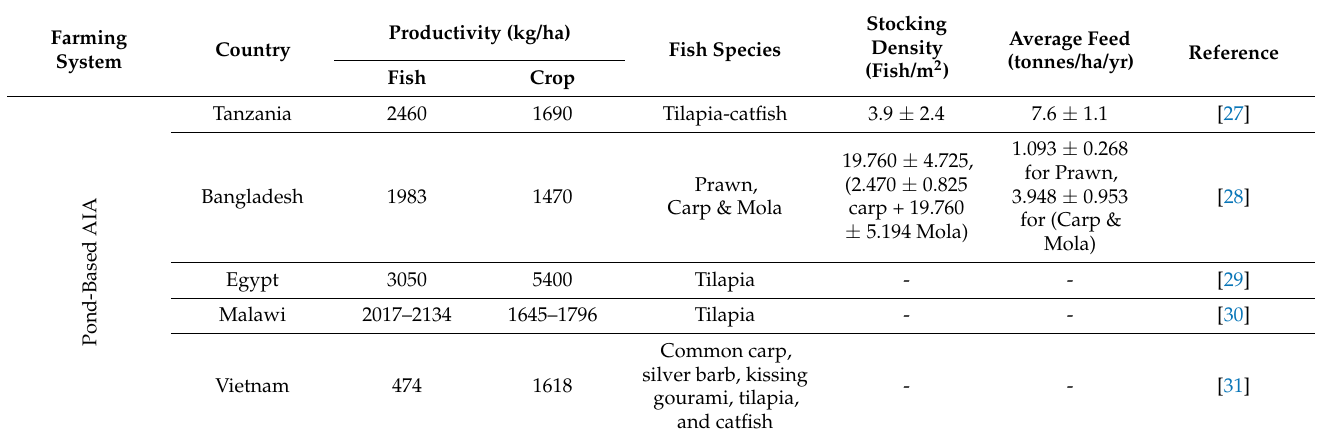
Table 5. Productivity of crops in pond-based AIA among different countries. Farming